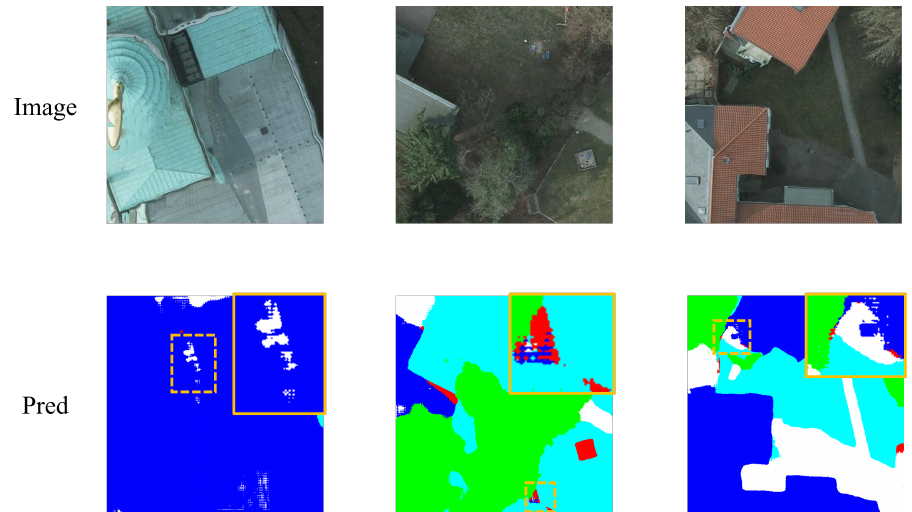
Figure 11. The failure cases of our proposed model. The failure parts are highlighted by the dashed yellow box, and the zoomed results are appended to the top right corner for better